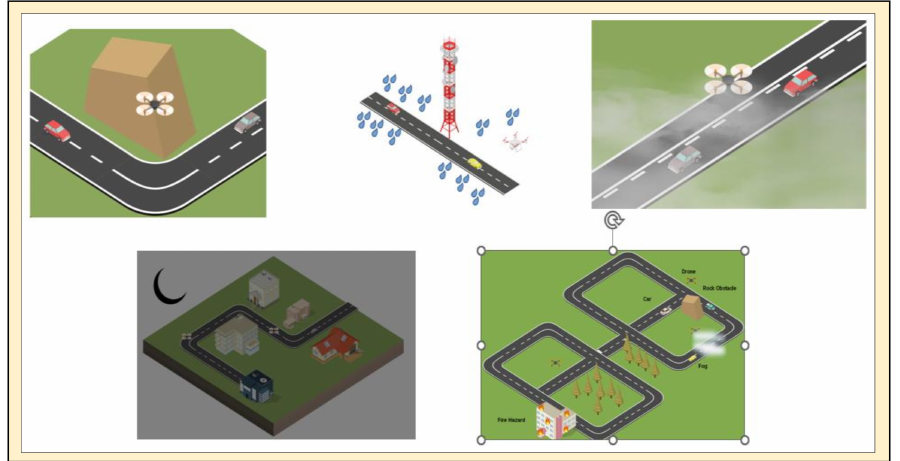
Figure 25. Various use cases were tested to validate our